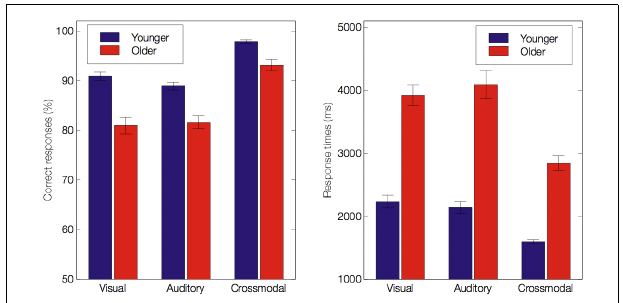
FIGURE 2 | Mean accuracy scores (%) and response times (ms) for both age groups under the visual, auditory and crossmodal conditions. Error bars indicate standard errors of the